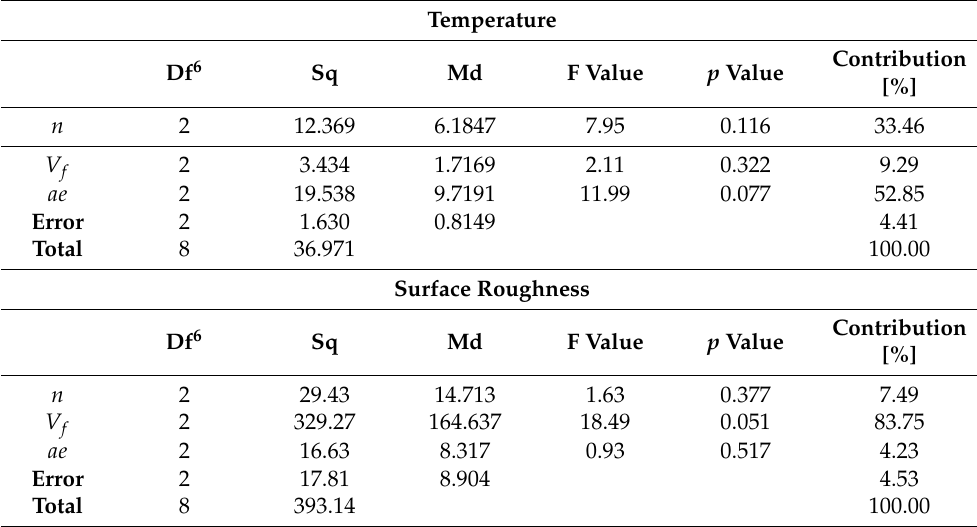
Table 15. ANOVA analysis for chip temperatures and surface roughness of the workpiece after machining tests with vegetable oil (100 mL/h).